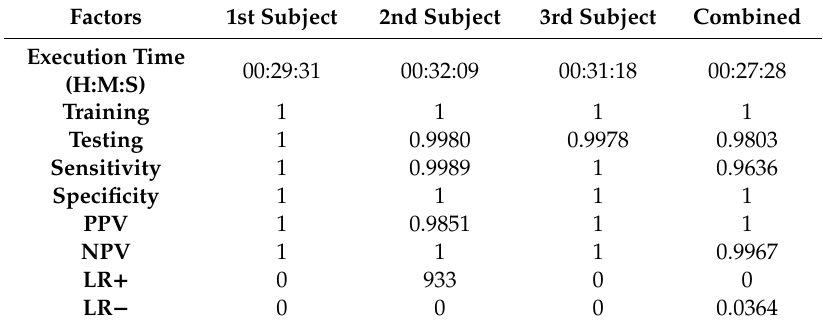
Table 4. Comparison the disparity between individual subjects and Combined using CNN for Training and